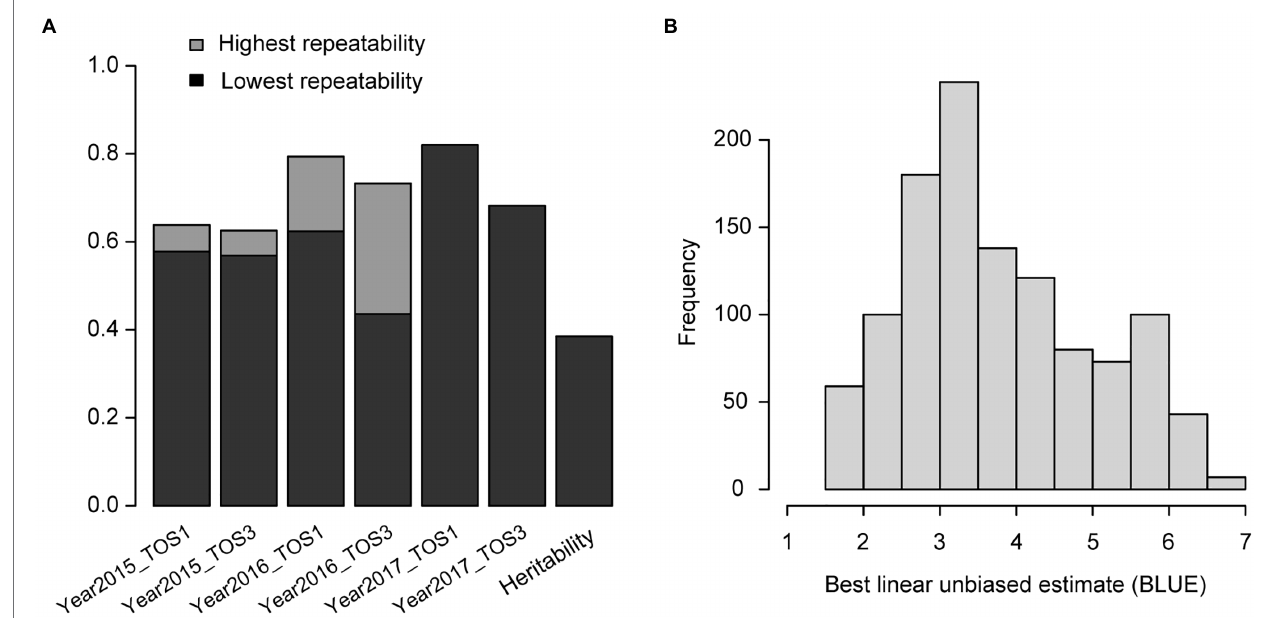
FIGURE 1 | Wheat – (A) heritability of grain yield and repeatability in each environment. The highest and lowest repeatability of specific environments evaluated in different data sets are shown in two grayscales; (B) distribution of best linear unbiased estimate (BLUE) of genotypes in different